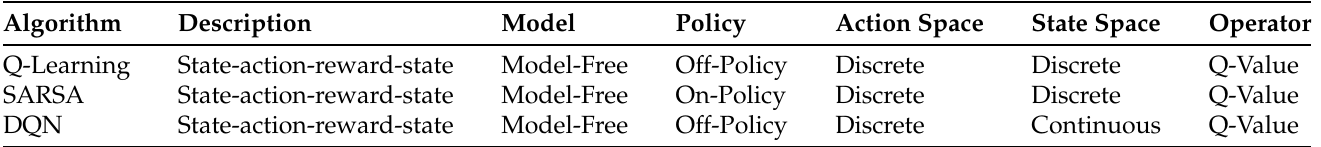
Table 1. Type of agent